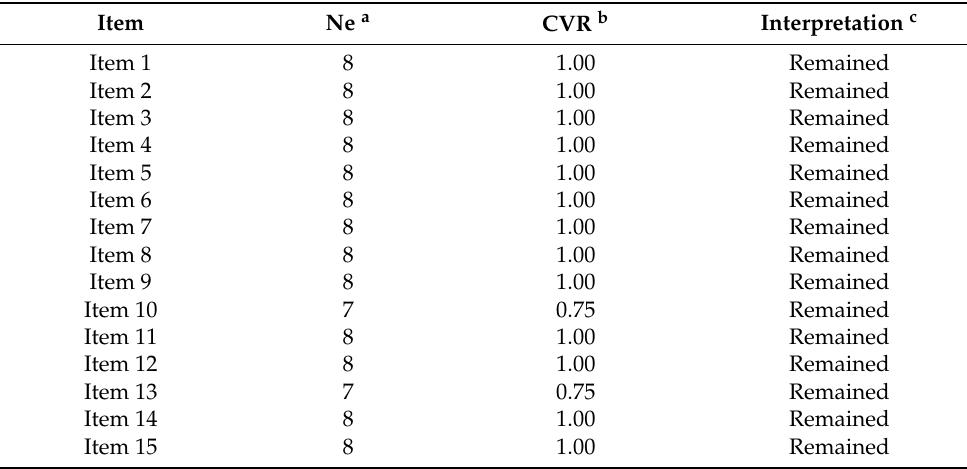
Table A1. Content validity ratio for the ISS through the expert panel ( N =